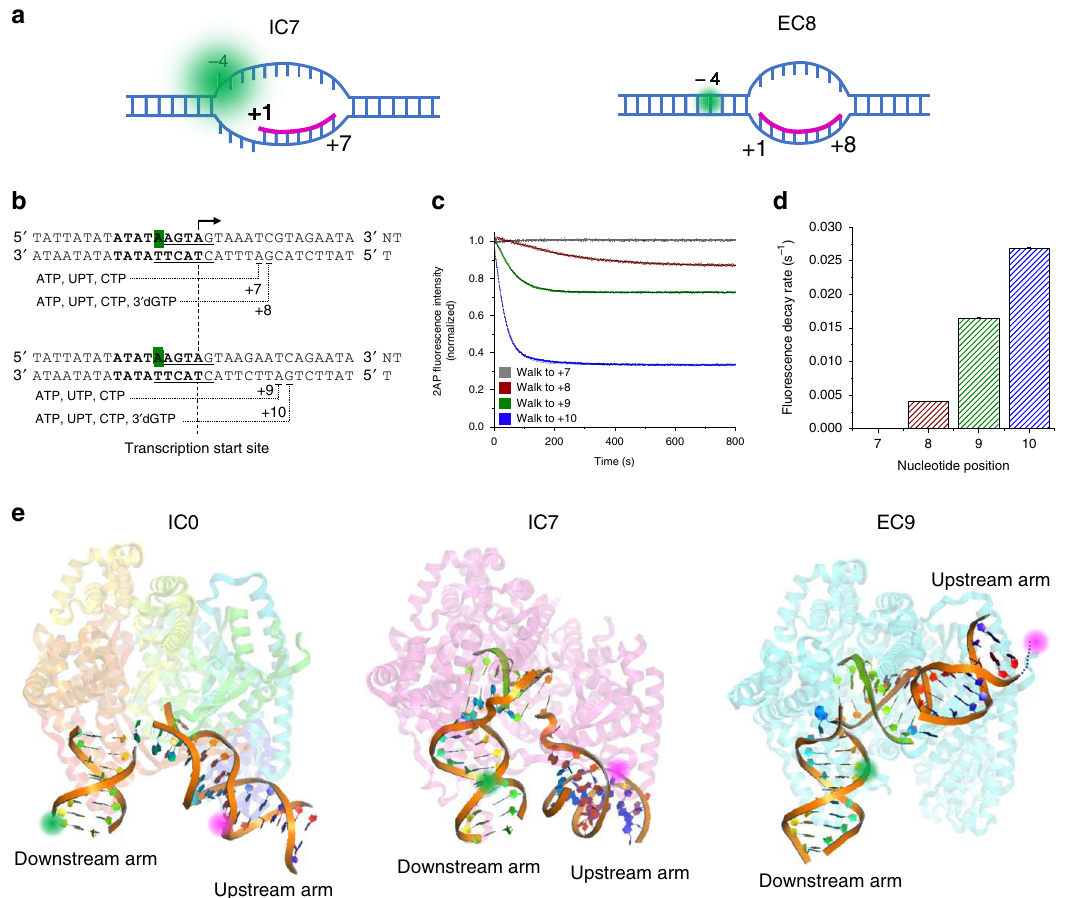
Fig. 3 The transcription initiation bubble collapses upon transition to elongation. a Schematic illustration showing IC7 with the initiation bubble and a 7- nt RNA (magenta) annealed to the template DNA from positions + 1 to + 7. The template bases from − 4 to − 1 are single stranded, resulting in a strong fl uorescence signal of 2AP at position − 4 of the non-template strand (green). At position + 8, EC8 is shown where the initiation bubble has collapsed and the − 4 to − 1 region is reannealed, resulting in the quenching of 2AP fl uorescence. b Design of DNA templates used for 2AP fl uorescence measurements, to be stalled at positions + 7, + 8, + 9, and + 10. c Changes in 2AP fl uorescence measured along in vitro transcription reactions to the indicated positions, normalized against the initial intensity. The intensity traces were fi t to a single-exponential decay curve to determine the transition rates. d Fluorescence decay rates measured from c at different walking positions. e Models of the IC0, IC7, and EC9 structures generated using PyMOL (Schrödinger, USA). IC0 was modeled using PDB 6erp (human mitochondrial RNA polymerase initiation complex), IC7 was modeled using PDB 3e2e (bacteriophage T7 RNA polymerase initiation complex with 7 bp RNA:DNA), and EC9 was modeled using PDB 4boc (human mitochondrial RNA polymerase elongation complex with 9 bp RNA:DNA). The green and magenta balls represent the Cy3 and Cy5 fl uorophores at positions + 11 and − 11, respectively. The double-stranded DNA and RNA:DNA hybrid (RNA in green) is highlighted as bound to the protein in